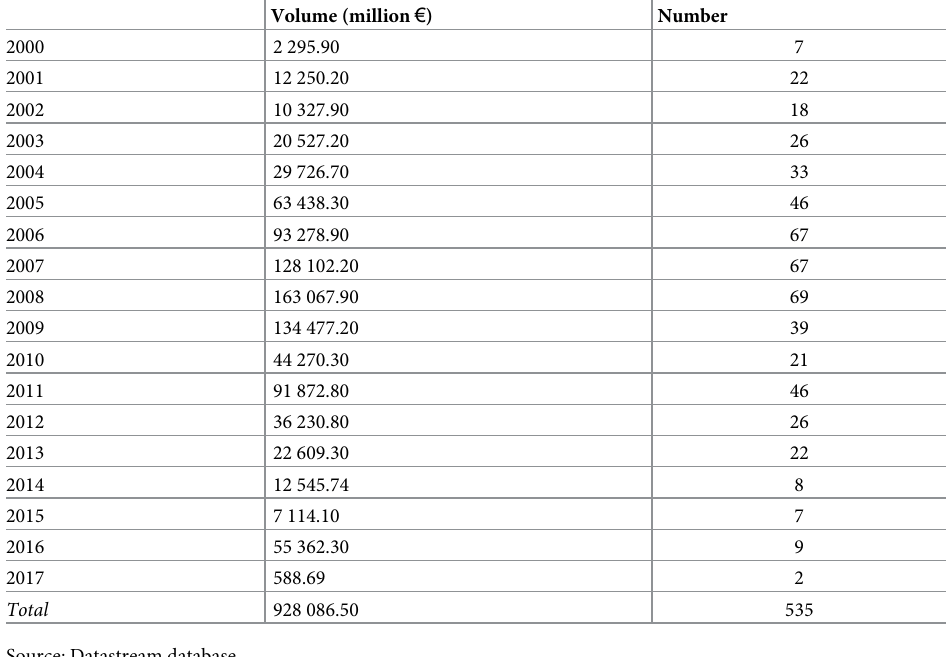
Table 2. Volume and number of issues for the whole sample for each year. Volume (million € )